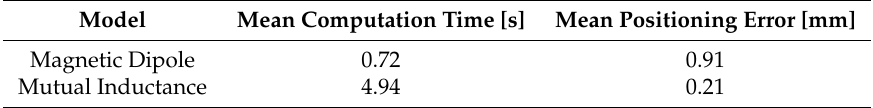
Figure 8. Simulation results: comparison of the mean computation time obtained for different values of the SNR. Table 1. Numerical simulation results: mean computation time and mean positioning error for each position calculation, with SNR = 81